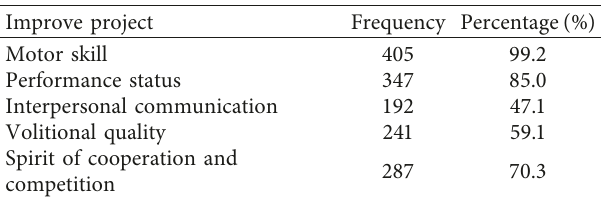
Table 12: Improvement project for University students after teaching reform ( n �